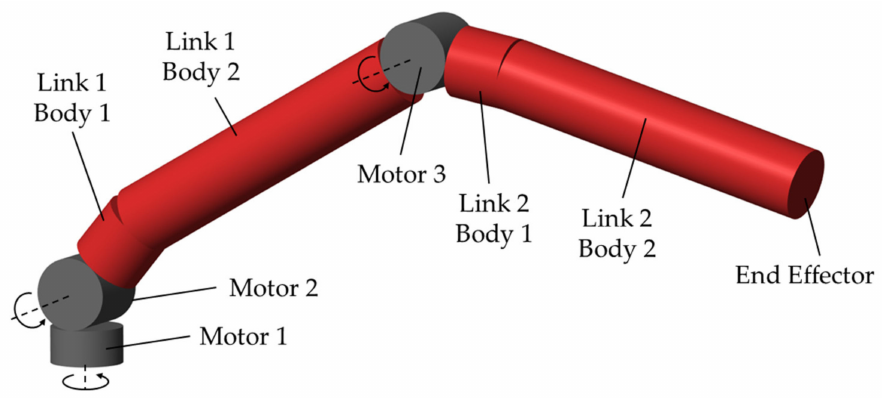
Figure 3. Robot 3D